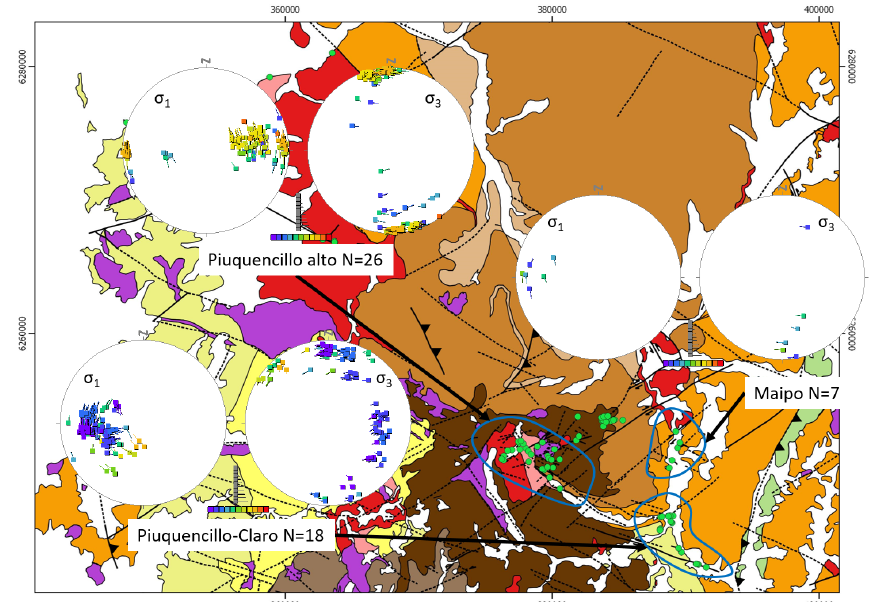
Figure 13. Dynamic analysis of fault-plane data by sector. Clarillo–La Obra and San Pedro de Nolasco sectors are not considered, as the minimum of four fault planes with reliable kinematic indicators, necessary for stress state calculations, was not achieved in these areas. The geological map in the background was compiled from Rivera and Cembrano (2000), SERNAGEOMIN (2002), Fock (2005), Fock et al. (2005), Piquer (2015) and this work.